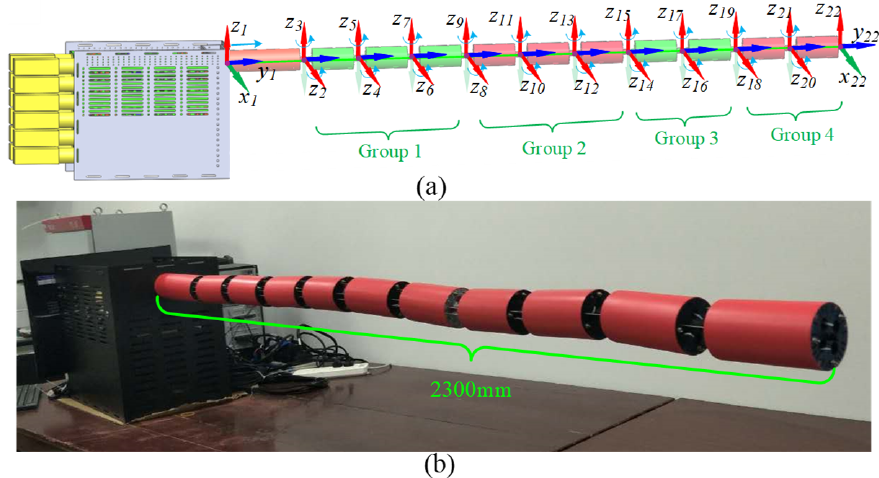
Figure 2. SAM design model ( a ) and prototype ( b ).